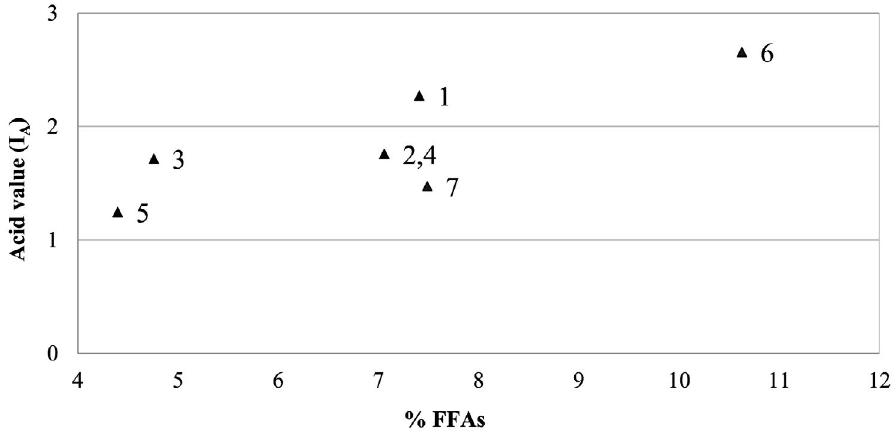
Fig 9. I A values correlated to the % FFAs (w/w) in PS 20 (1-5) and PS 80 samples